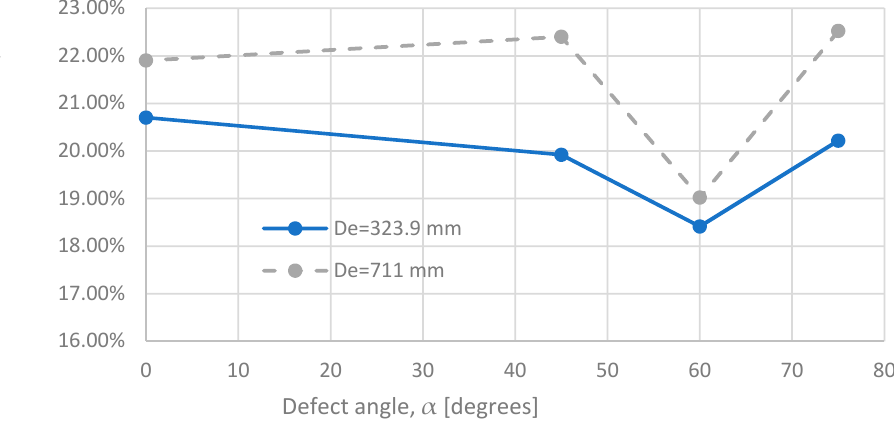
Figure 16. Relative difference, RD , between the maximum equivalent von Mises stress value and the allowable stress limit, for both pipes, type II composite and d rd = 0.3.